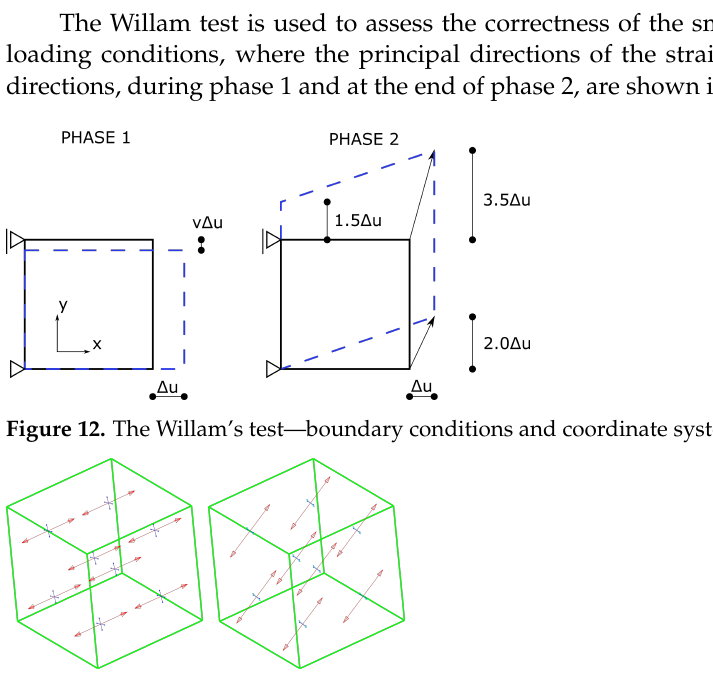
Figure 13. Willam’s test—principal directions at the end of phase (from left): 1 and 2.